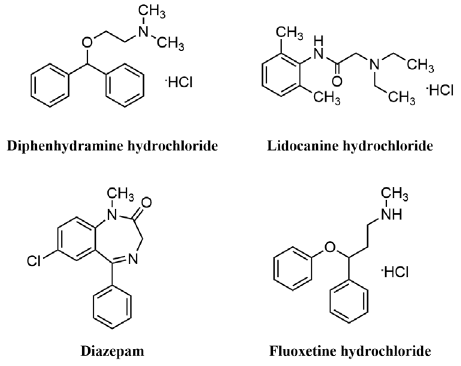
Figure 9. T he structures of the drugs